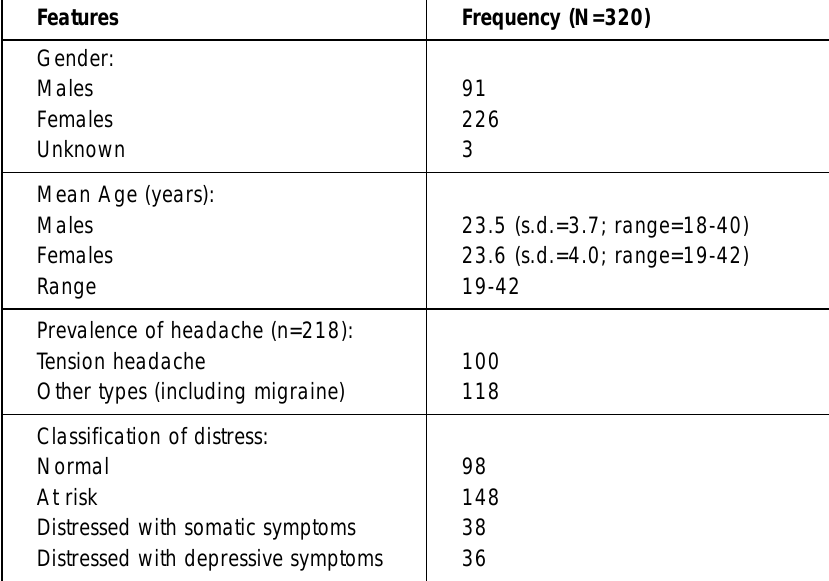
Table 1: Characteristics of the students Features